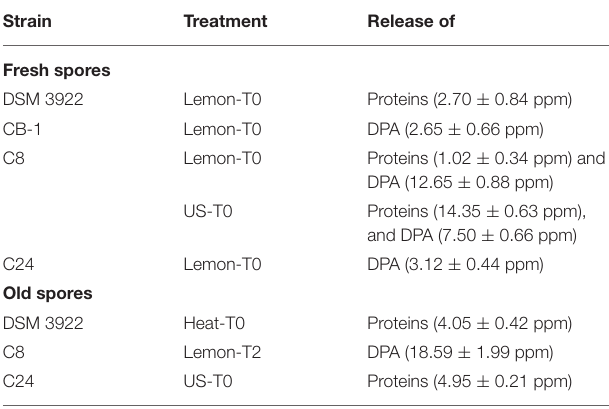
TABLE 2 | Release of proteins and DPA from fresh and old spores of A. acidoterrestris after lemon extract (250 ppm) addition (lemon), US